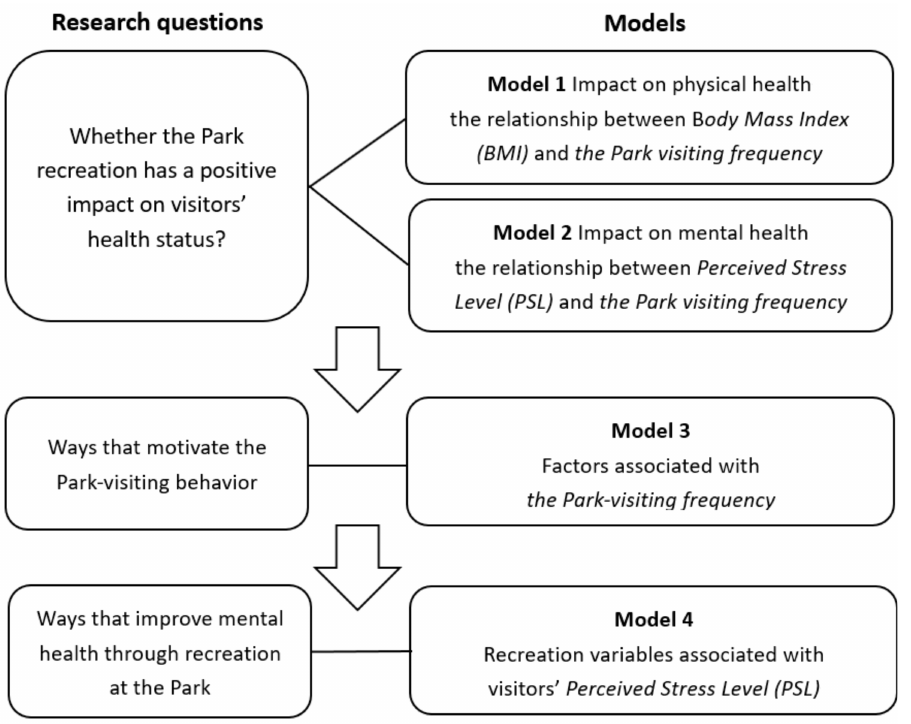
Figure 3. Logic flow of setting up the econometric